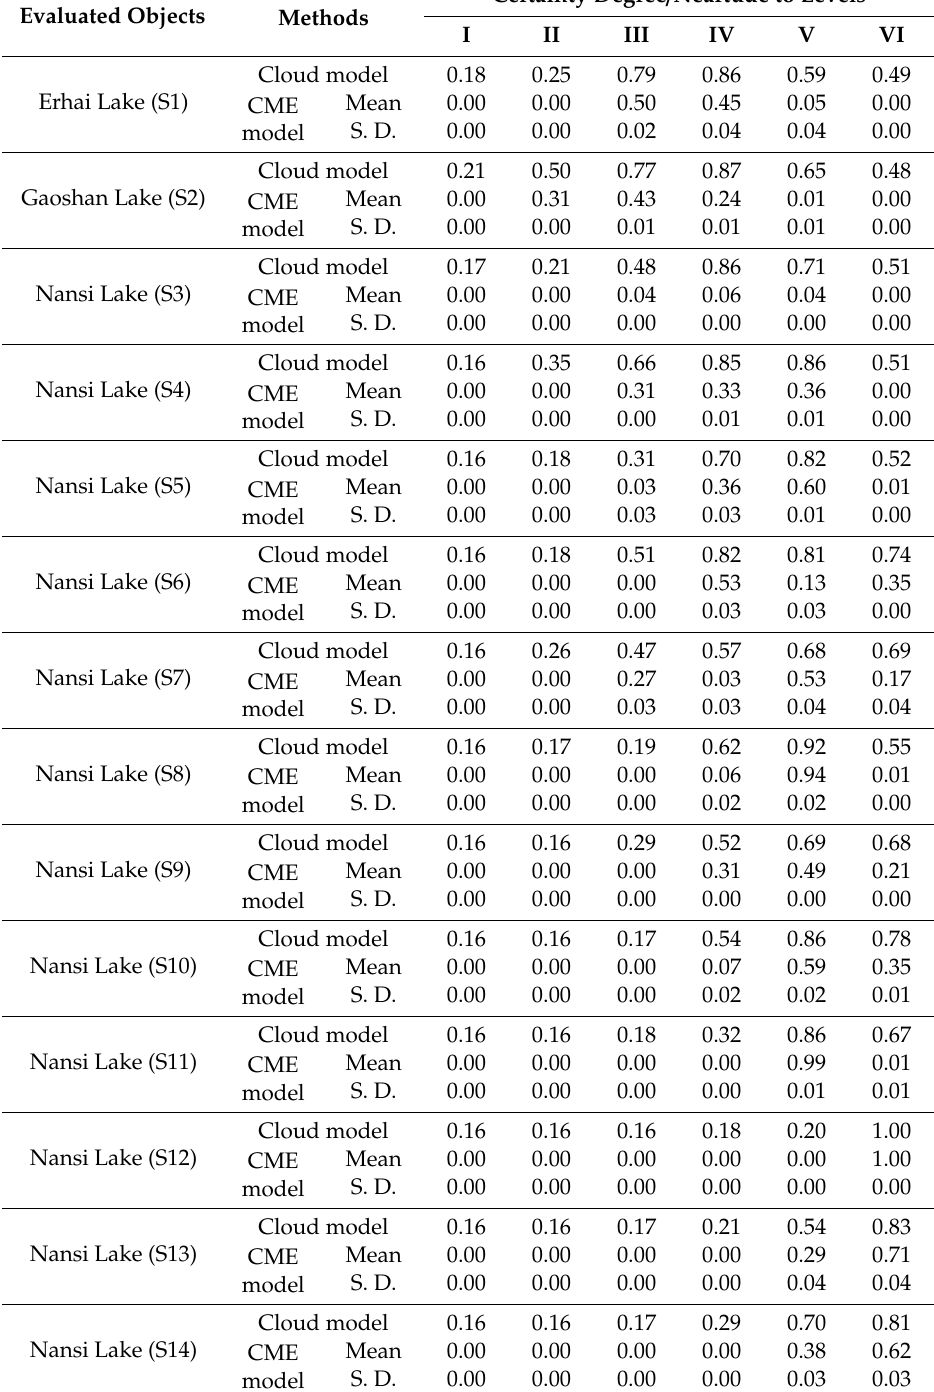
Table A2. The comparison of cloud model and CME for 24